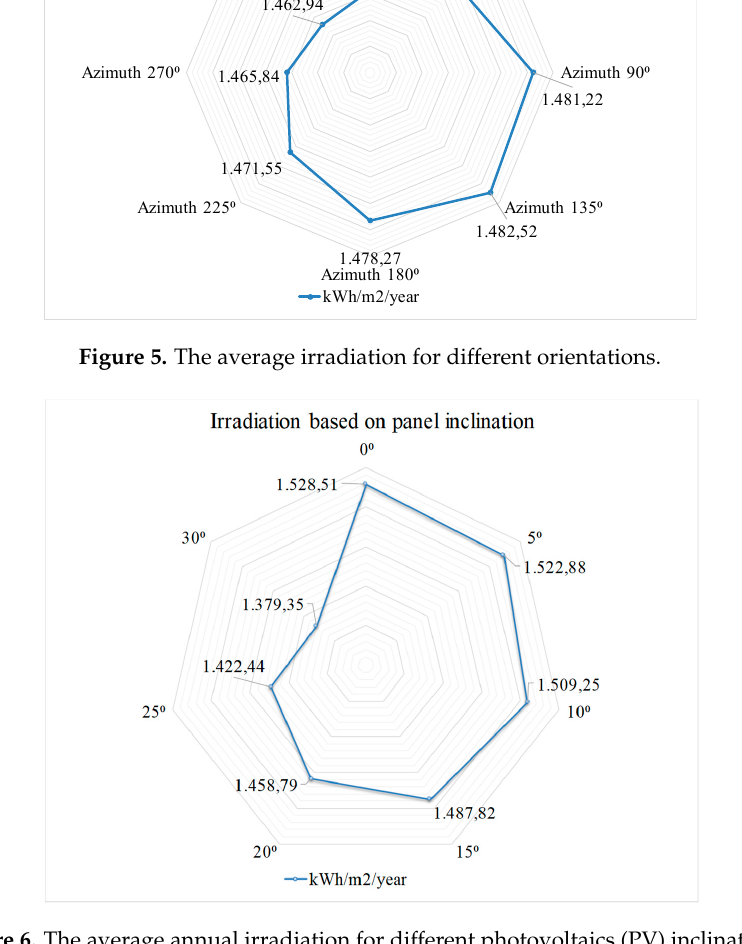
Figure 6. The average annual irradiation for different photovoltaics (PV) inclinations The average annual irradiation on a horizontal surface in the city is 1528.51 kWh/m 2 . Comparing the minimum and maximum irradiation values when the orientation varies, a 3 to 4% variation is observed under the different orientations of the PV panels. Adopting the most critical case, Cor = 0.96 is used. When analyzing the inclination, a difference of up to 10% is observed between the maximum